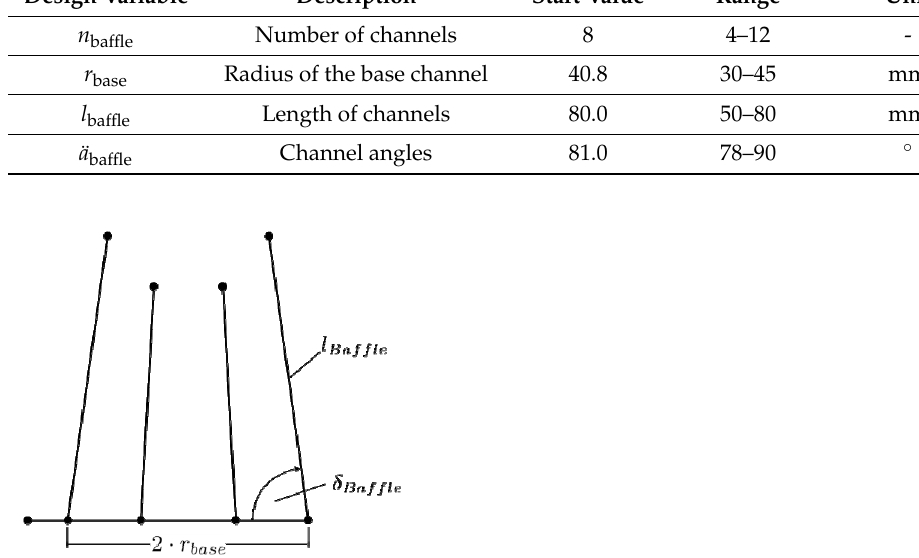
Figure 8. Graphical representation of the design variables for the optimization of the conventional cooling system. Table 3. Design variables for the optimization of the conventional cooling system.